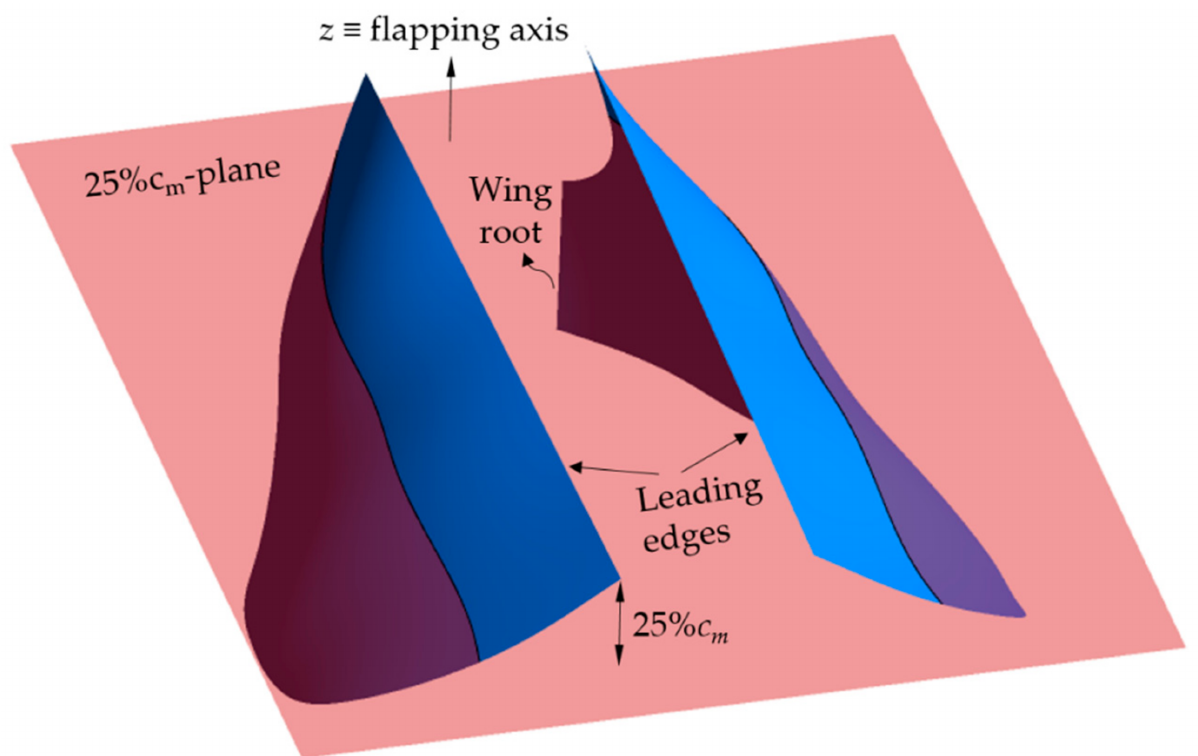
Figure 21. Definition of 25% c m